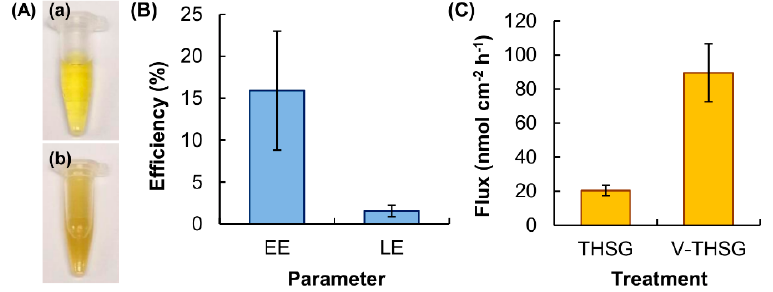
Figure 3. ( A ) Images of solutions of ( a ) THSG and ( b ) V-THSG. ( B ) The EE and LE of the vesicles. Data are presented as the means ± SD of triplicate experiments. ( C ) The transdermal flux of THSG from the plain THSG solution and the V-THSG solution. Data are presented as the means ± SD of triplicate experiments.